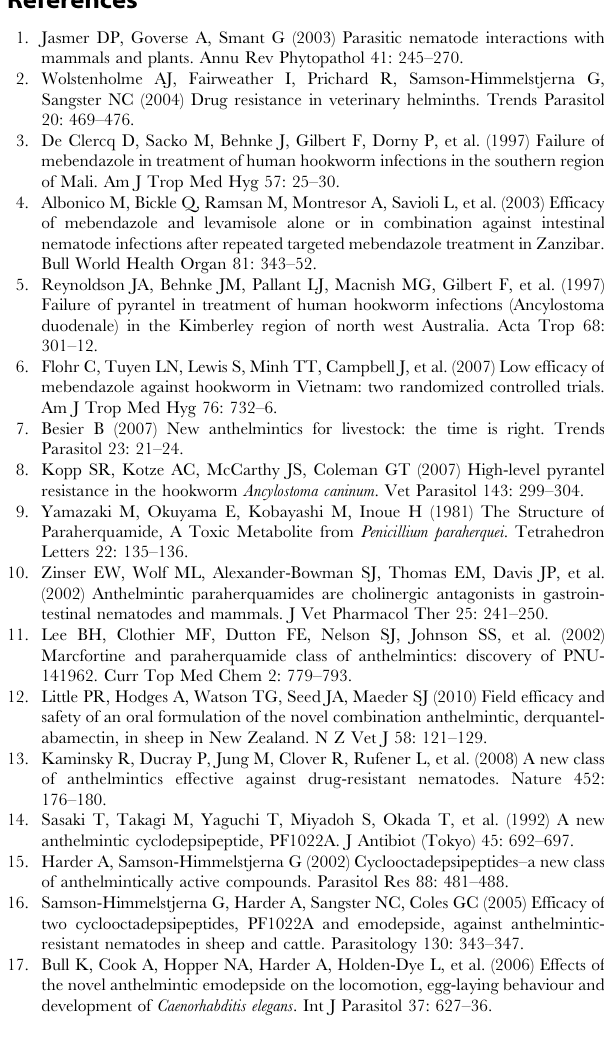
target the mere coding sequence, but the reverse primer anneals to the untranslated region (3 9 -UTR) coded by the vector. Therefore, in untransformed animals no amplification can be achieved using this primer pair. Table S3 Overview of constructs used for